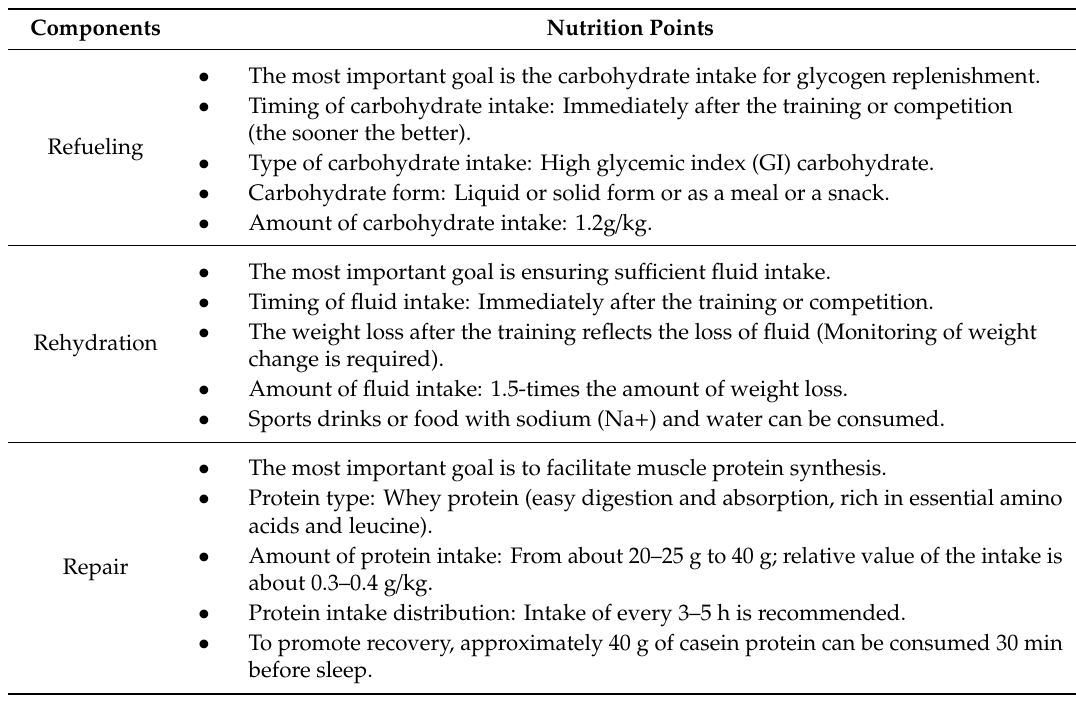
Table 3. Nutrition points for the recovery of rowing